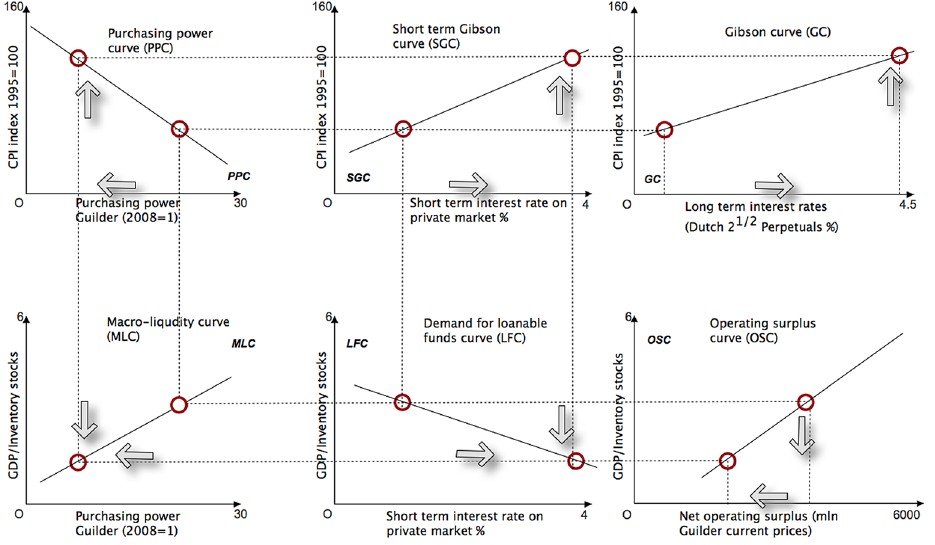
Fig. 3 . Gibson paradox curve model (the Netherlands 1900–1950) Source : authors’